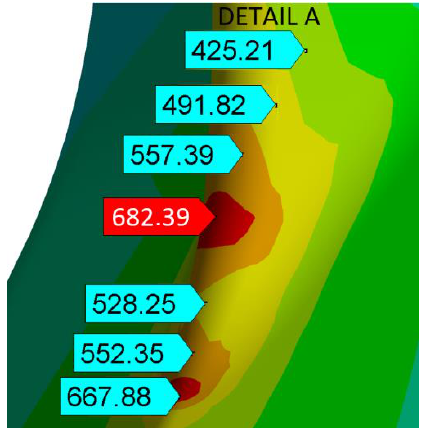
Figure 14. Detail “A” (see Figure 13) of the location with the maximum equivalent stress (von Mises) in the medial staple and with marked values near the maximum (MPa).